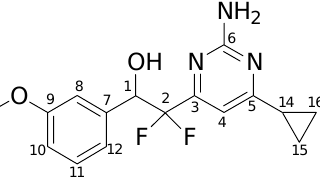
Figure 2. Numbering of carbon atoms of compound 4h , used for assignment of 13 C-NMR